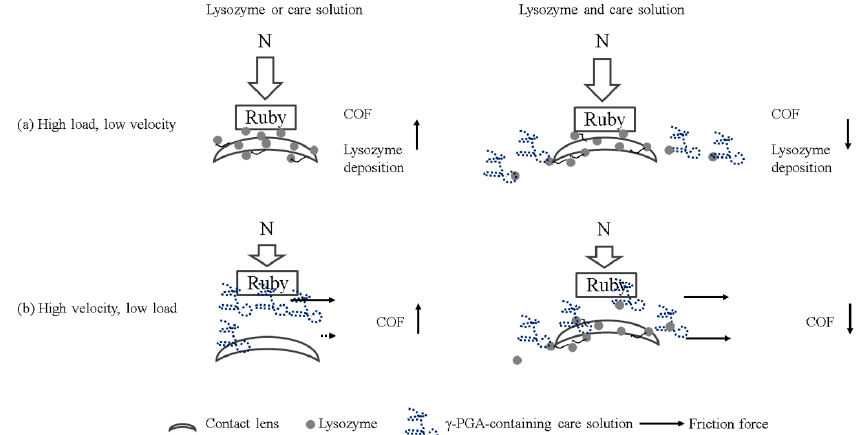
Figure 5. The potential mechanism of the bio-tribological effect of γ -PGA in the lysozyme-ionic contact lens system. ( a ) When Etafilcon-A is sliding against a ruby ball under a high normal load, lysozyme deposition is increased resulting in an increase of friction coefficient ( left ). When γ -PGA is present, γ -PGA can bring lysozyme away from the surface resulting in a reduction of both lysozyme deposition and friction coefficient ( right ). ( b ) When Etafilcon-A is sliding under fast velocity, γ -PGA interacts differently with Etafilcon-A and with ruby resulting in an uneven friction force on two surfaces. The differential friction forces result in an increase in friction coefficient ( left ). In contrast, the interaction between γ -PGA and lysozyme may be stronger resulting in an even friction force on two surfaces. Therefore, the friction coefficient of γ -PGA-containing care solution and lysozyme is reduced in this condition ( right ).